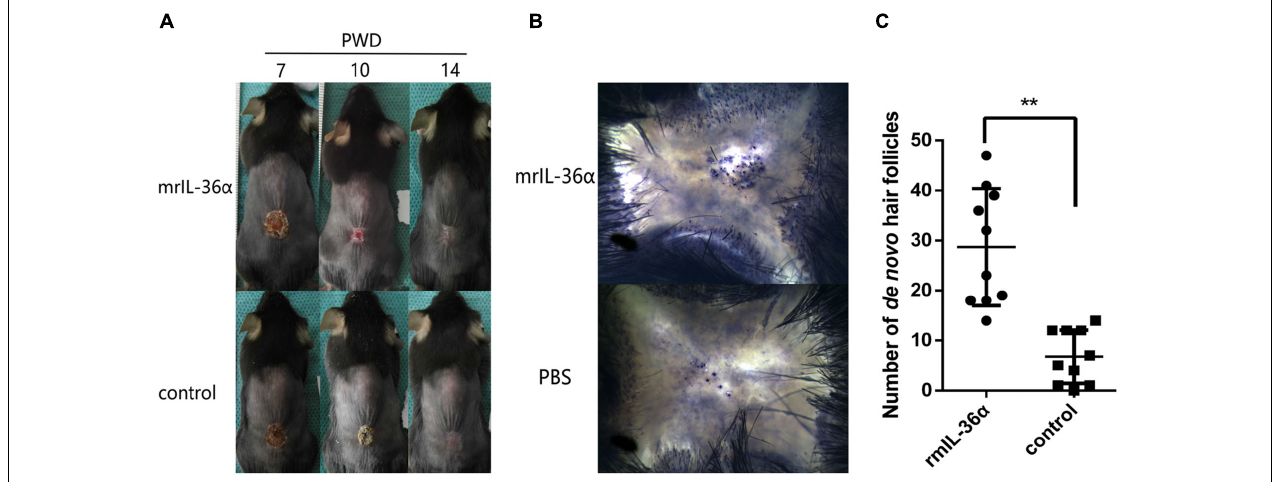
FIGURE 3 | IL-36 α promotes wound epithelialization and wound induced hair follicle neogenesis. A full-thickness wound of 1.5 × 1.5 cm 2 square was made. A total of 50 µ L of 1 ng/ µ L mrIL-36 α dissolved in PBS or PBS only was injected into the healing wound (beneath the scab into the granulation tissue) from post-wound day (PWD) 7–14. (A) Wound model photographs of murine recombinant IL-36 α (mrIL-36 α )-injected group ( n = 10) and control group ( n = 10). (B) De novo hair follicles in skin stained for alkaline phosphatase activity at PWD 28. (C) De novo hair follicle counting in wild type mice after single dose of mrIL-36 α (50 ng) compared to PBS control (** p < 0.005, n =